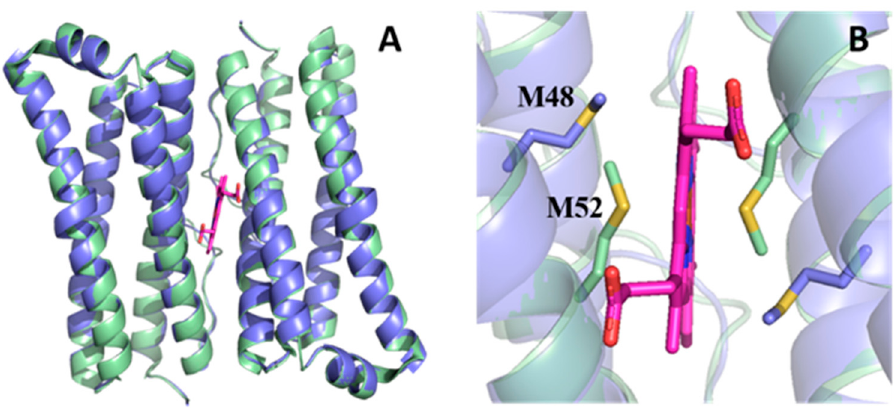
Figure 1. Structural comparison of recombinantly expressed BfrB (PDB ID 5D8O) and FtnA (PDB ID 3R2K) proteins. ( A ) Superposed subunit dimers of BfrB (pale green) and FtnA (slate blue) viewed along the two-fold axis of symmetry; the heme in the BfrB subunit dimer is in magenta. ( B ) Zoomed-in view of the heme, which, in a BfrB subunit dimer, is axially coordinated by Met52 from each subunit (sulfur atoms in yellow). Met48 in the FtnA subunits is too far from the heme to form axial bonds with the heme iron.